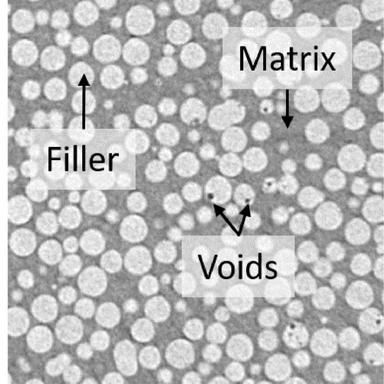
A magnified view of a single 2D slice from the µCT scanned F-NR4, which was compressed using a SHPB, showing the matrix, fillers and voids.